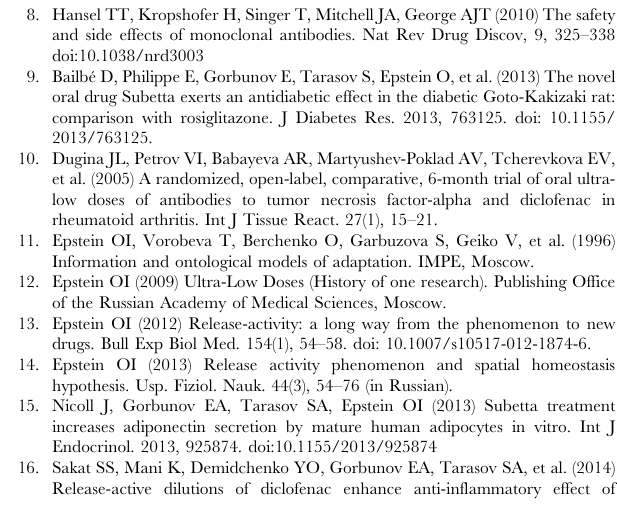
Table S1 The occupancy of microtiter plates (A) and optical density values (B) in Experiment 1. Table S2 The occupancy of microtiter plates (A) and optical density values (B) in Experiment 2. Table S3 The occupancy of microtiter plates (A) and optical density values (B) in Experiment 3. Table S4 The occupancy of microtiter plates (A) and optical density values (B) in Experiment 4.